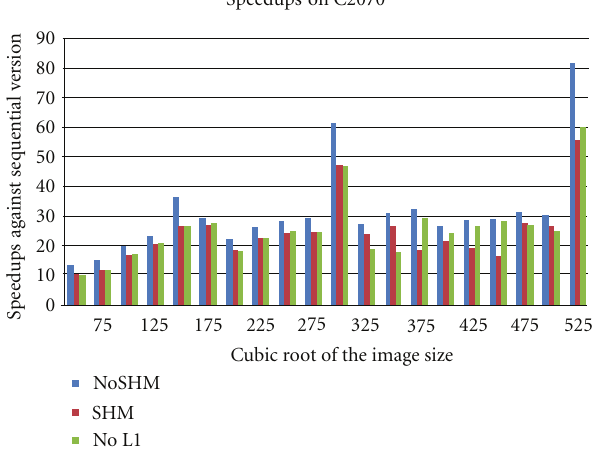
Figure 9: The overall speed up of the algorithm on the C2070 system for di ff erent image sizes (with the data transfer times excluded).